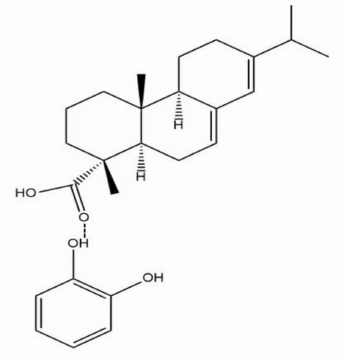
Figure 7. Possible complexes for WW rosin and LLE.